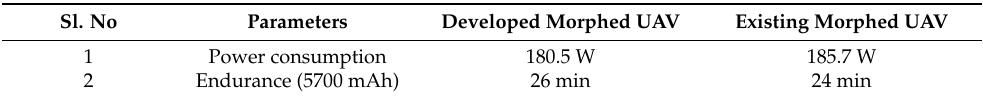
Table 5. Flight endurance comparison between existing morphed MUAV and developed mor- phed MUAV.